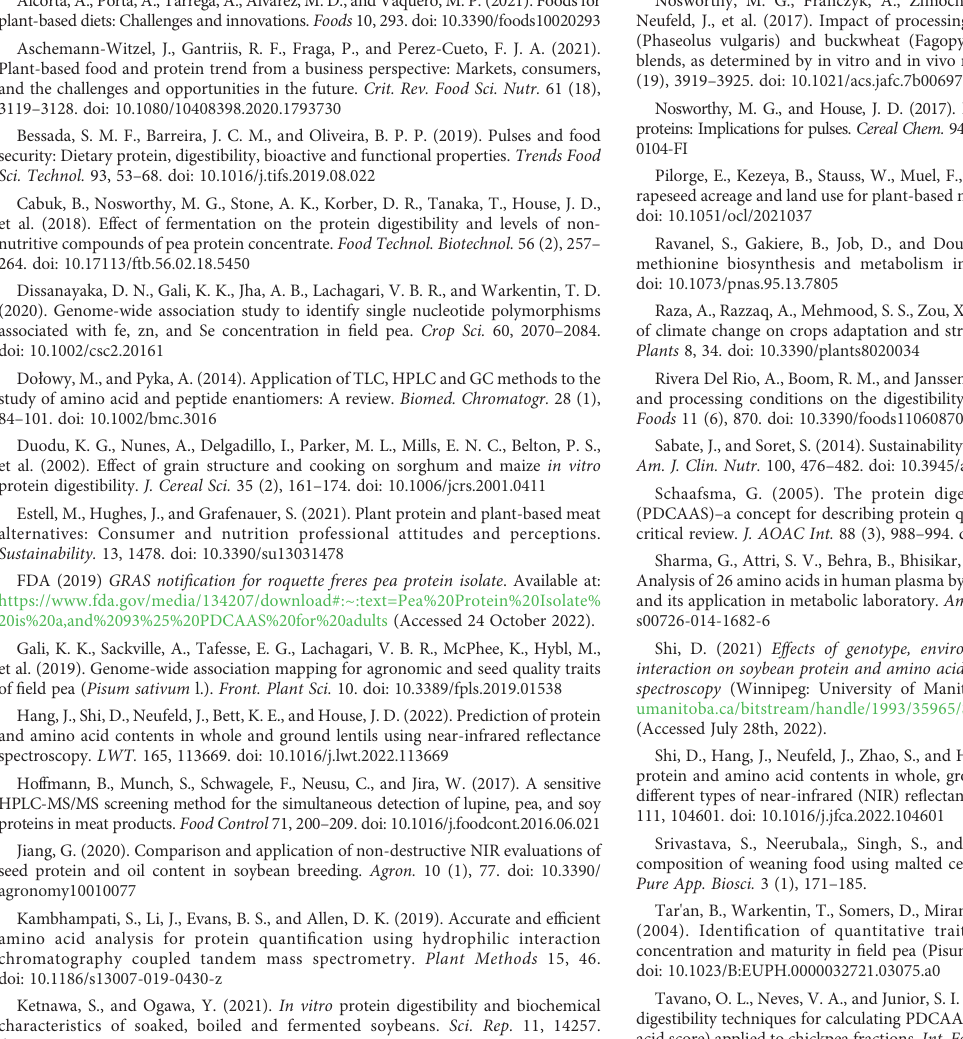
SUPPLEMENTARY FIGURE 1 Individual QTL analysis from each station-year in PR-25 reveals the QTLs associated for methionine + cysteine concentration. Individual QTL analysis was based on average phenotypic data of biological replicates in each station-year. SUPPLEMENTARY FIGURE 2 Individual QTL analysis from each station-year in PR-25 reveals the QTLs associated for tryptophan concentration. Individual QTL analysis was based on average phenotypic data of biological replicates in each station-year.